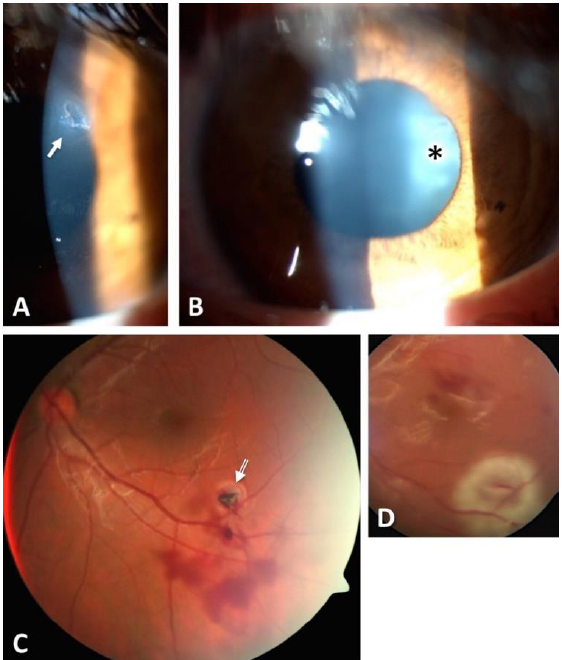
Figure 3. One case with a zone I injury. Penetration of a foreign body at the limbus. Open globe injury with small corneal entrance wound (arrow) ( A ), punctured lens (asterisk) ( B ) and retinal impact ( C ) by a small metallic foreign body (arrow). Intraoperative situation after removal of the foreign body, laser retinopexy and silicone-oil filling ( D ).